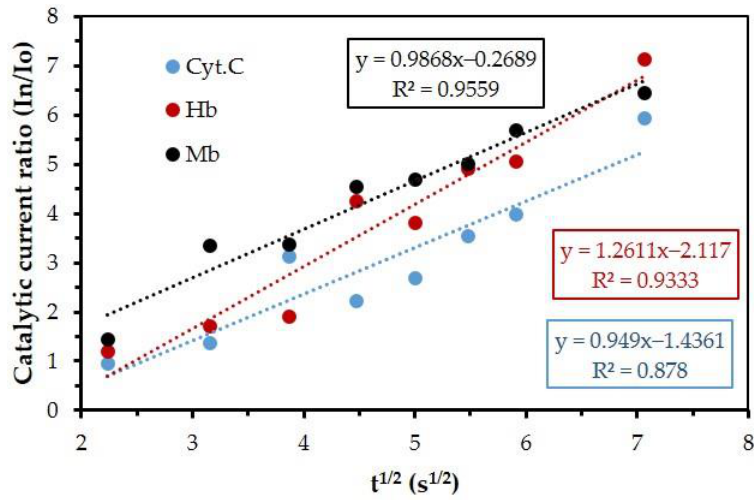
Figure 11. Catalytic current ratio (I n /I o ) of hemeproteins versus t 1/2 where (red) Hb, (black) Mb, and (blue) Cyt. C reacted at the MB/GP film electrode in a pH 7 buffer solution.